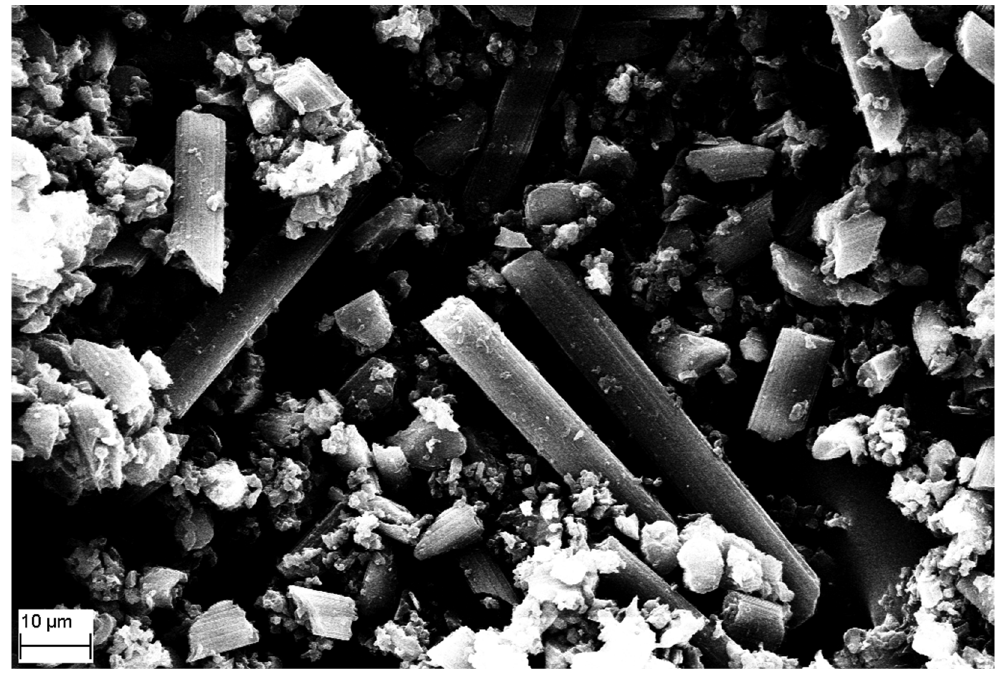
Figure 10. Deposited particles collected in a sampling tray placed directly below drilling from the EP/CF/GO 0.5 wt.%